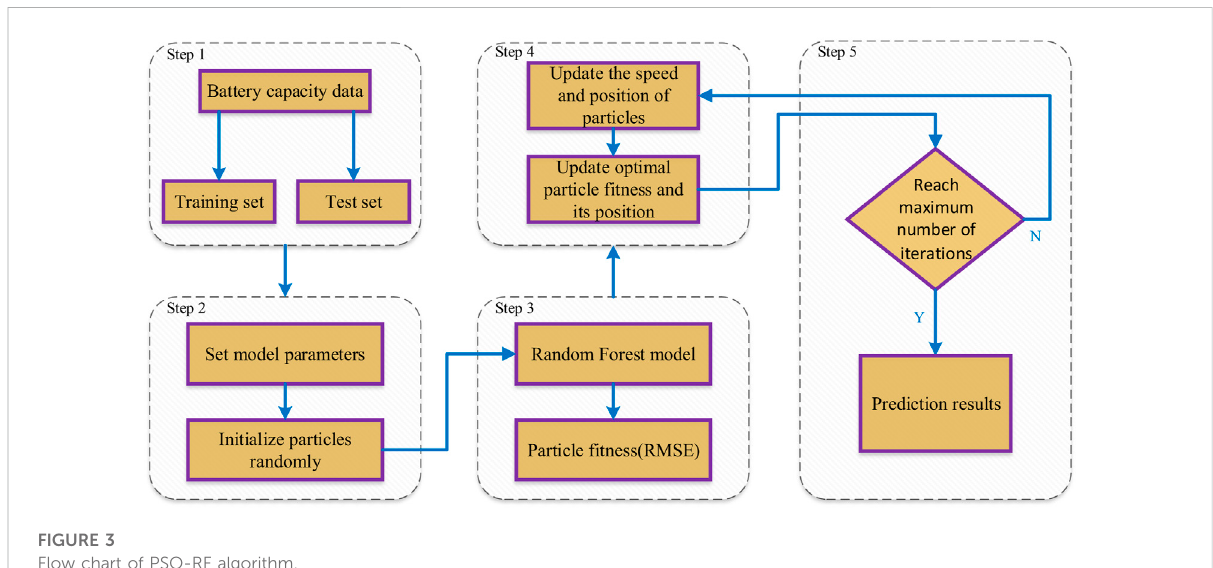
FIGURE 3 Flow chart of PSO-RF algorithm.